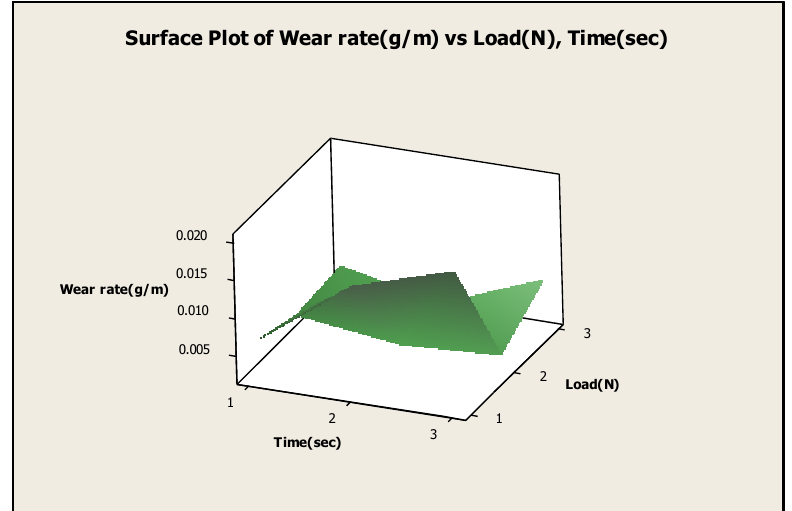
Surface Plot of Wear rate(g/m) vs Load(N),